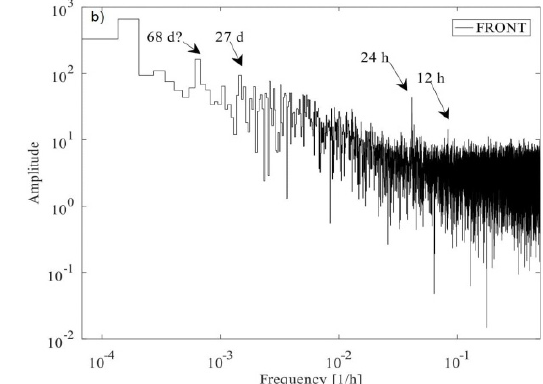
Figure 8. Discrete Fourier analysis of long-term muon intensity registered by scintillation detector TOP ( a ) and FRONT ( b ). Periodicities in time series 24 h (along with harmonics 12 h and 8 h), 27 d and 68 d have been